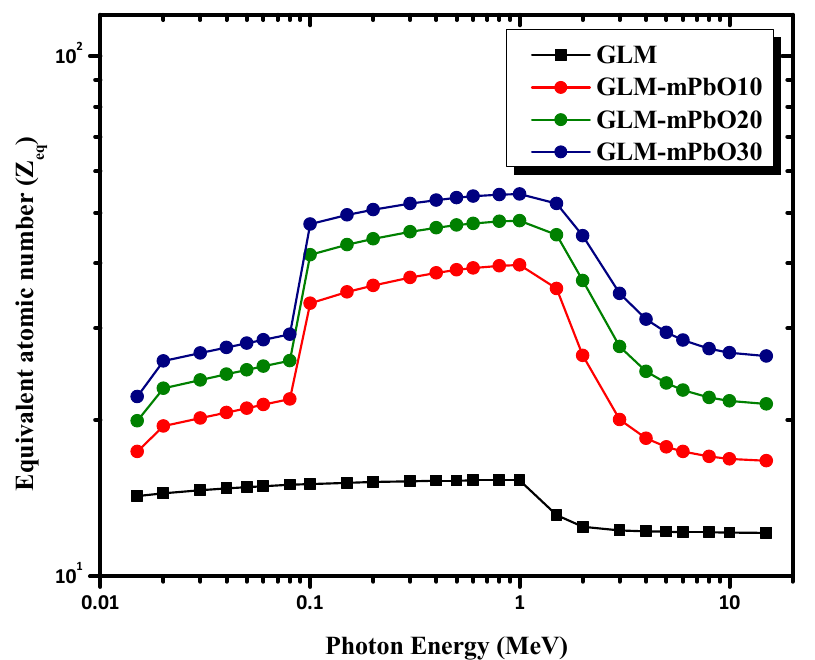
Figure 11. The variation of the Z eq with incident gamma-ray energy of mortars.